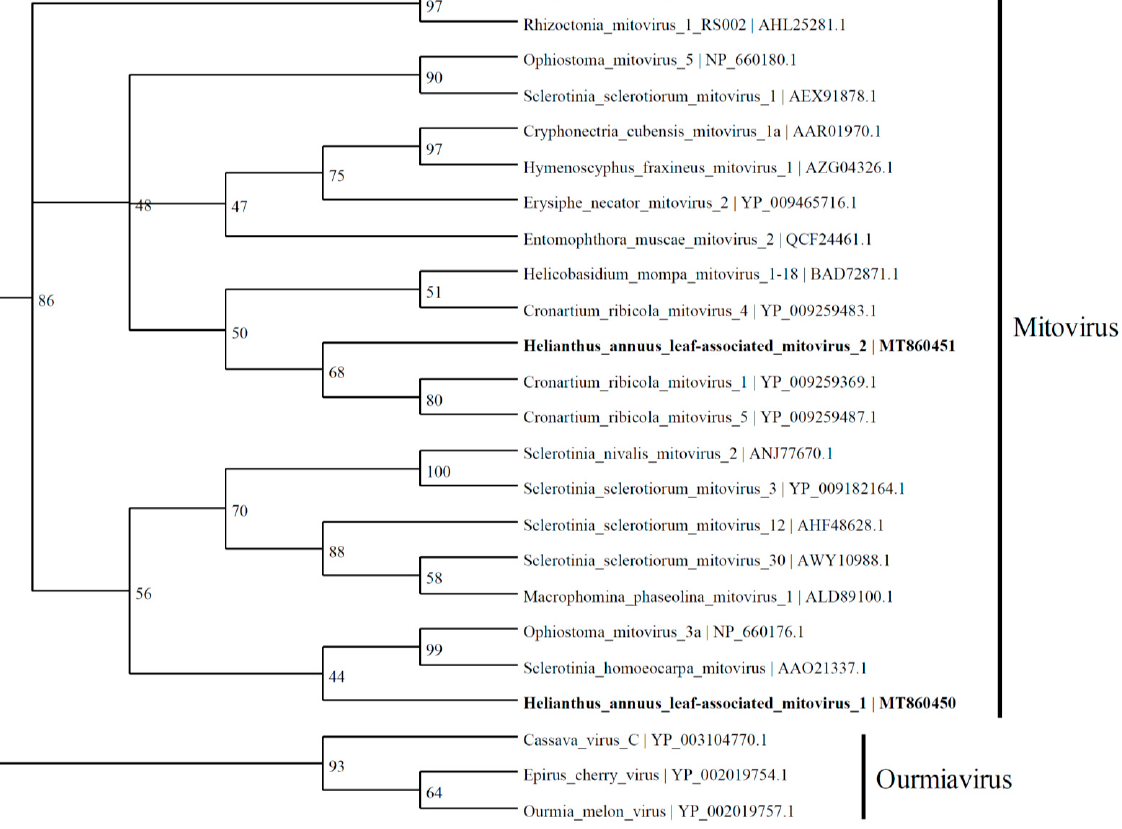
Figure 3. Phylogenetic tree depicting the relationships of the predicted amino acid sequence of RNA-dependent RNA polymerase of Helianthus annuus leaf-associated mitovirus 1 and Helianthus annuus leaf-associated mitovirus 2 with other confirmed and proposed members of the family Mitoviridae and genus Ourmiavirus .